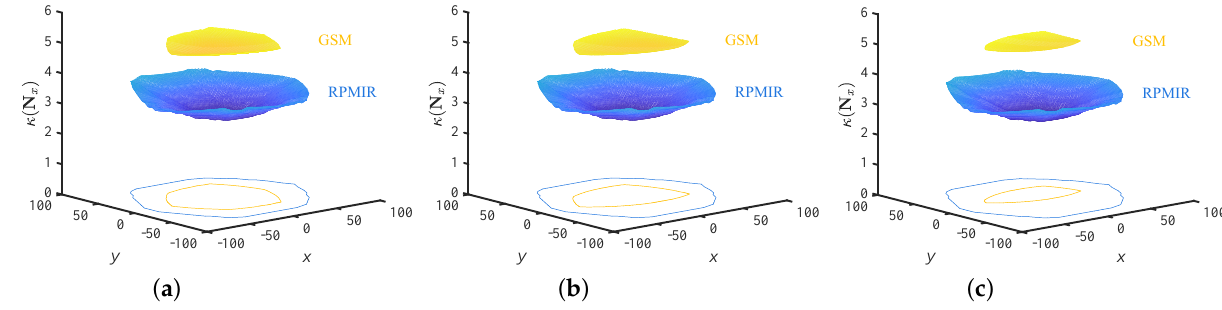
= [ 0 0 z ] T under cj j